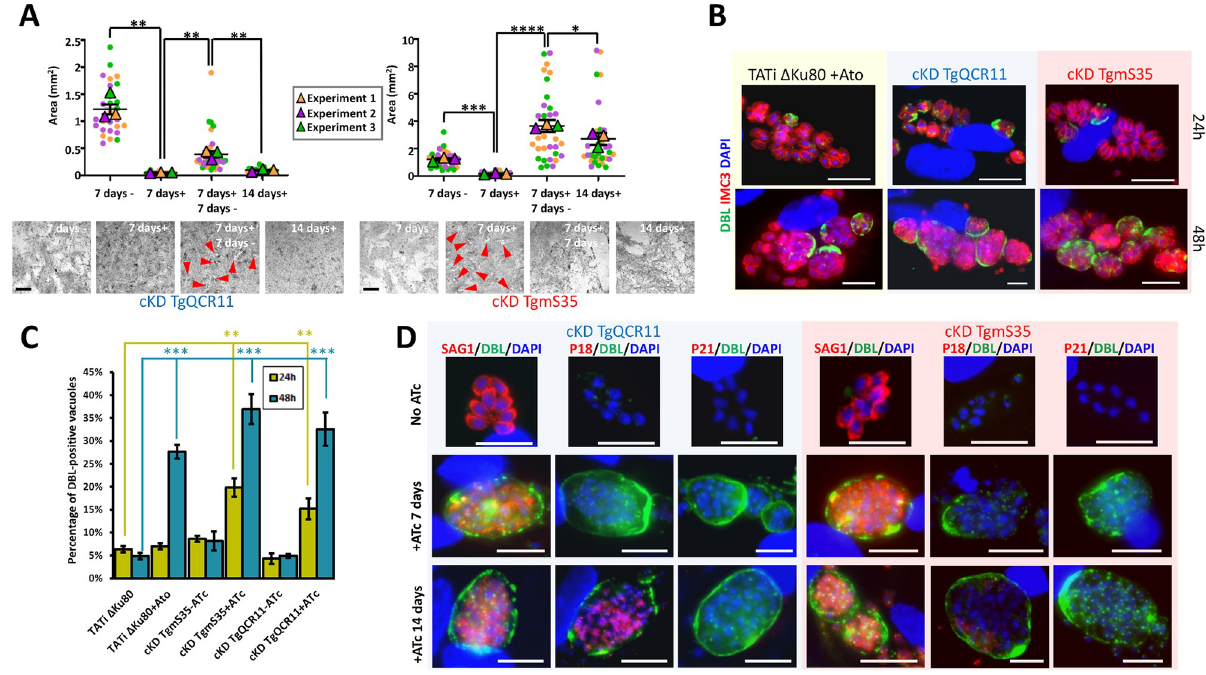
Fig 10. Other mitochondrial mutants remain viable and initiate stage conversion. A) Plaque assays for the TgQCR11 and TgmS35 mutants were performed by infecting HFF monolayers with cKD cell lines and letting them grow in absence (7 days -) or presence of ATc (7 days +), after 7 days ATc was washed out (7 days+ 7days-) or not (14 days+), and parasites were left to grow for an extra 7 days. Plaque area was measured. Data are means ± SEM from three independent experiments. � p � 0.05, �� p � 0.01, ��� p � 0.001, ���� p � 0.0001, Student’s t -test. Arrowheads show small plaques. Scale bar = 1mm. B) Tati Δ Ku80 parasites were grown in the presence of atovaquone and cKD TgQCR11 and TgmS35 parasites were grown in the presence of ATc for up to two days. They were labelled with anti-TgIMC3 (to outline parasites) and Dolicos biflorus lectin (DBL) to specifically outline nascent cyst walls. Scale bar represents 10 μ m. DNA was labelled with DAPI. DIC: differential interference contrast. C) Quantification of DBL- positive vacuoles after 24 hours or 48 hours of culture of 1) the cKD TgQCR11 and cKD TgmS35 mutants in the presence or absence of ATc 2) the Tati Δ Ku80 cell line in the presence or not of 1 μ M atovaquone. Data are from n = 3 independent experiments. Values are mean ± SEM. �� p � 0.01, ��� p � 0.001, Student’s t -test. D) The cKD TgQCR11 and cKD TgmS35 mutants were grown for up to 14 days in the presence of ATc and co-stained with early cyst wall marker DBL together with tachyzoite marker SAG1, or early (P18/SAG4), or late (P21) bradyzoite markers. Scale bar represents 10 μ m. DNA was labelled with